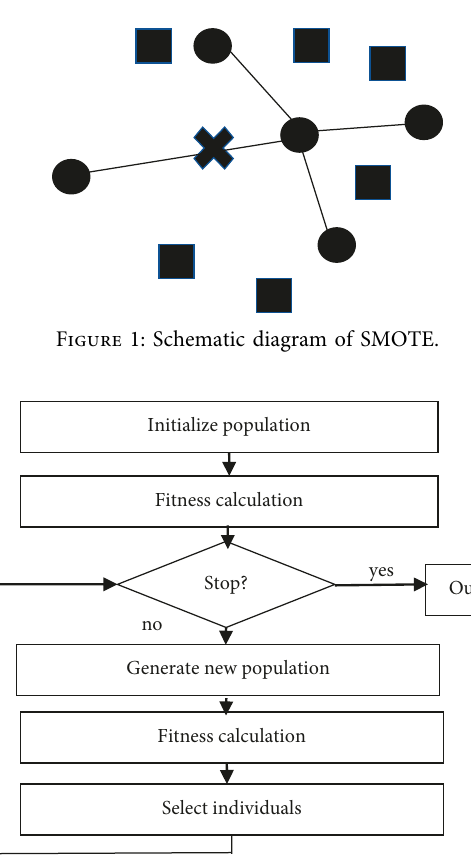
Figure 2: Flowchart of genetic